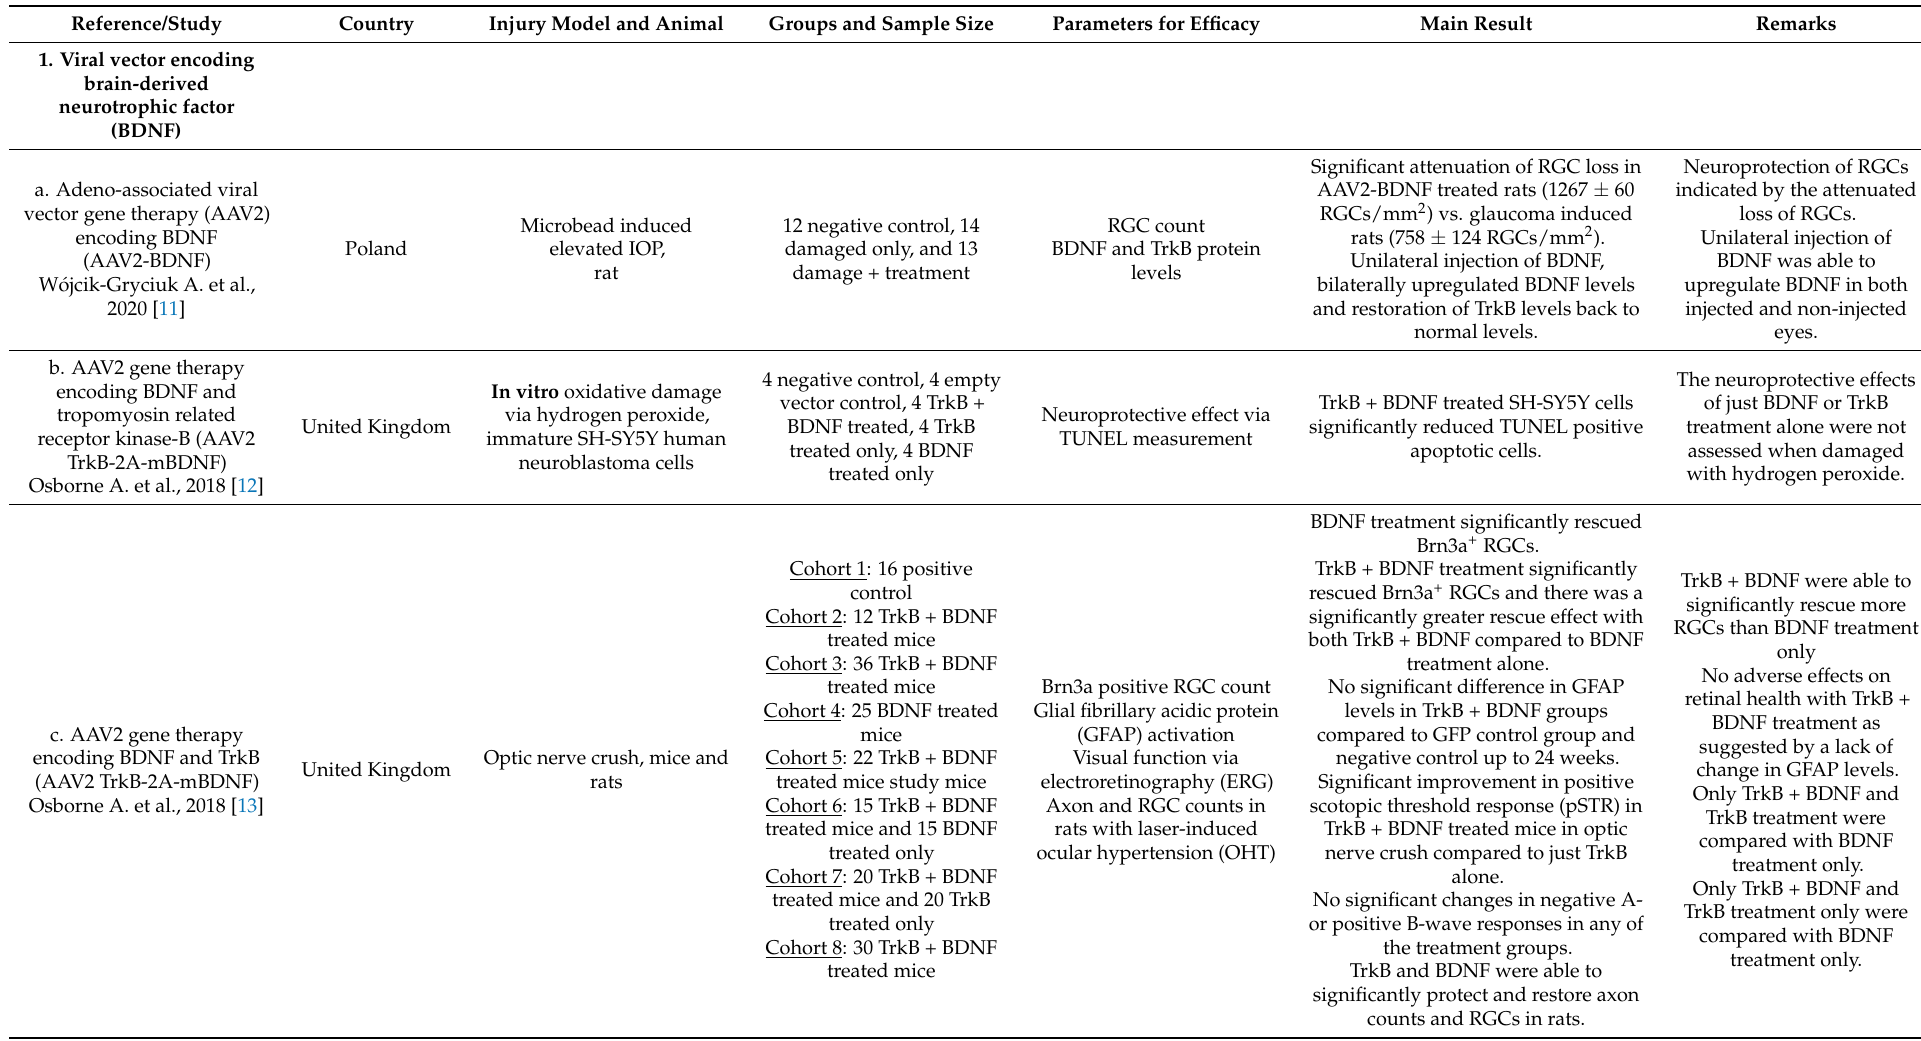
Table 1. Summary of in vivo and in vitro studies utilizing an adeno-associated viral (AAV) vector encoding brain-derived neurotrophic factor (BDNF) as gene